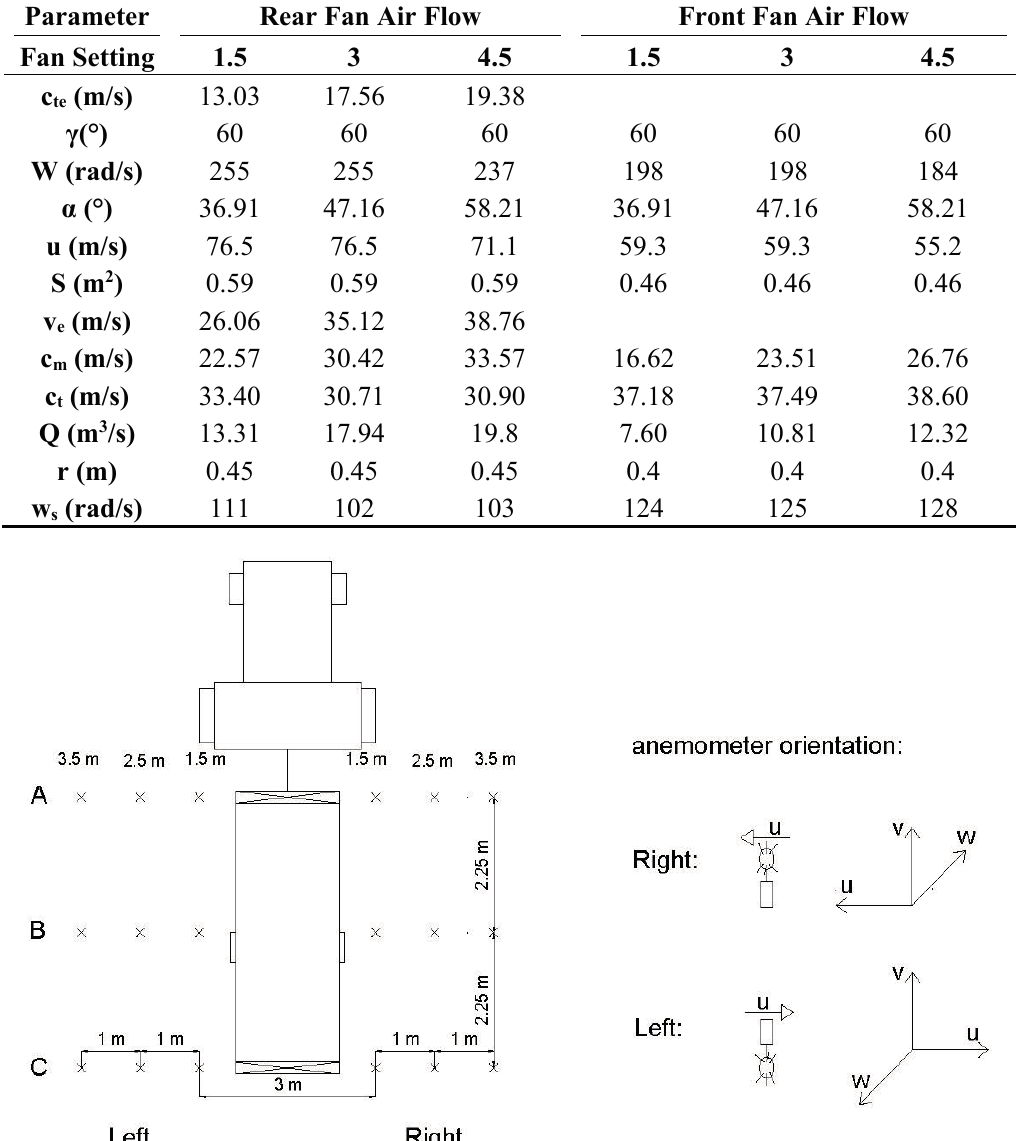
Figure 3. Measuring points and anemometer orientation used for static analysis of the sprayer operating and